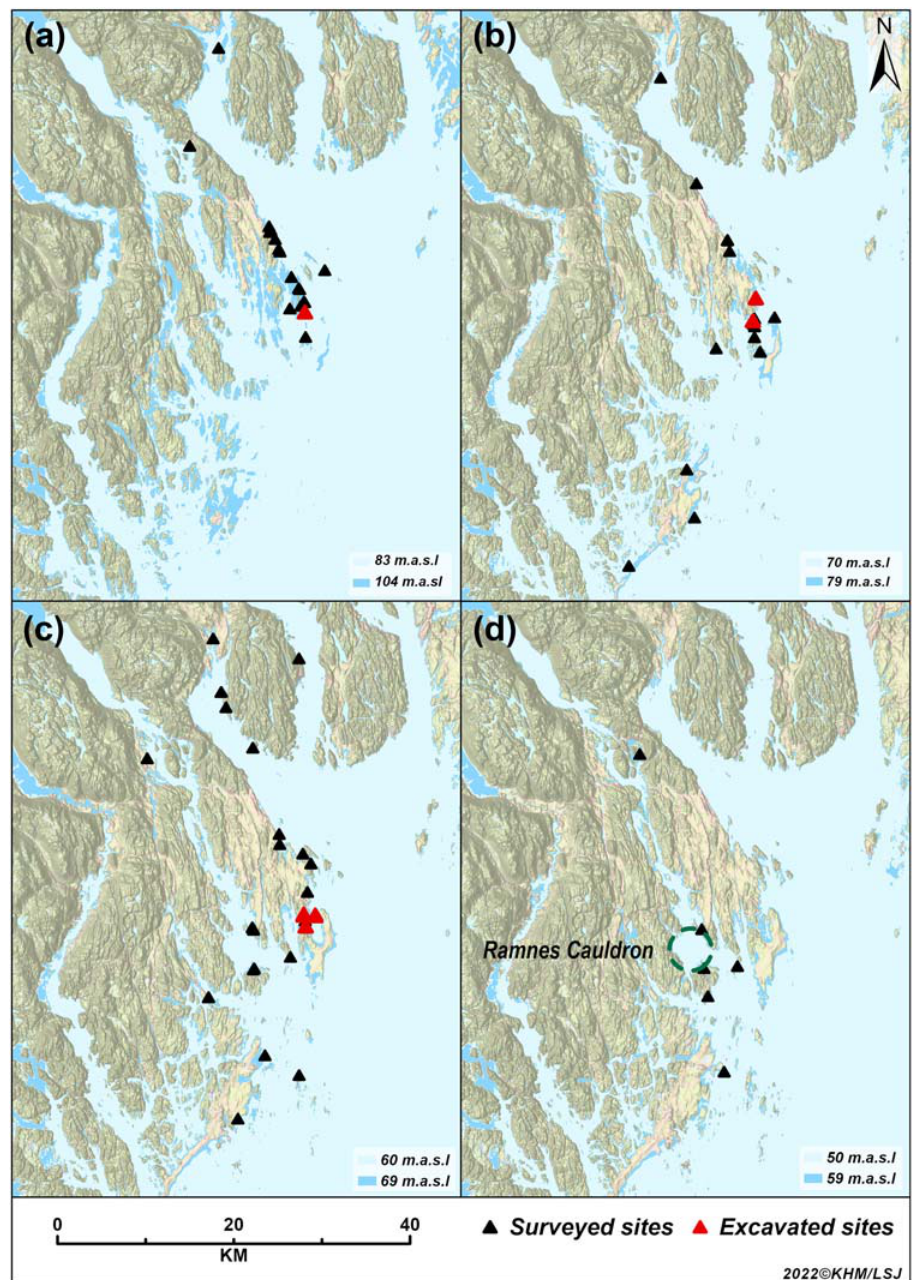
Figure 11: Development in the geographical distribution of MM sites ( n = 77, including eight excavated sites ) at 4 chronological stages ( a − d ) of the shoreline regression: ( a ) 8000 – 7800/7600 cal BCE; ( b ) 7700/7500 – 7300/7100 cal BCE; ( c ) 7300/ 7100 – 7000/68000 cal BCE; ( d ) 6900/6600 – 6300/6000 cal BCE. Some of the sites are situated very close, hence overlapping in the maps. For data see Supplementary File 6. Map: Linnea S. Johannessen, MCH, University of